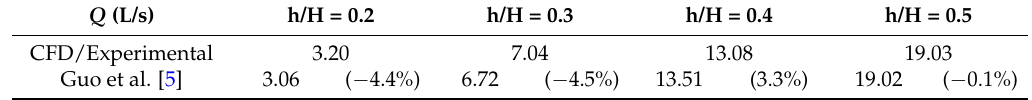
Table 3. Comparison of CFD/experimental discharges with the values obtained from Guo et al.’s formula [5]. Relative errors are in parenthesis.